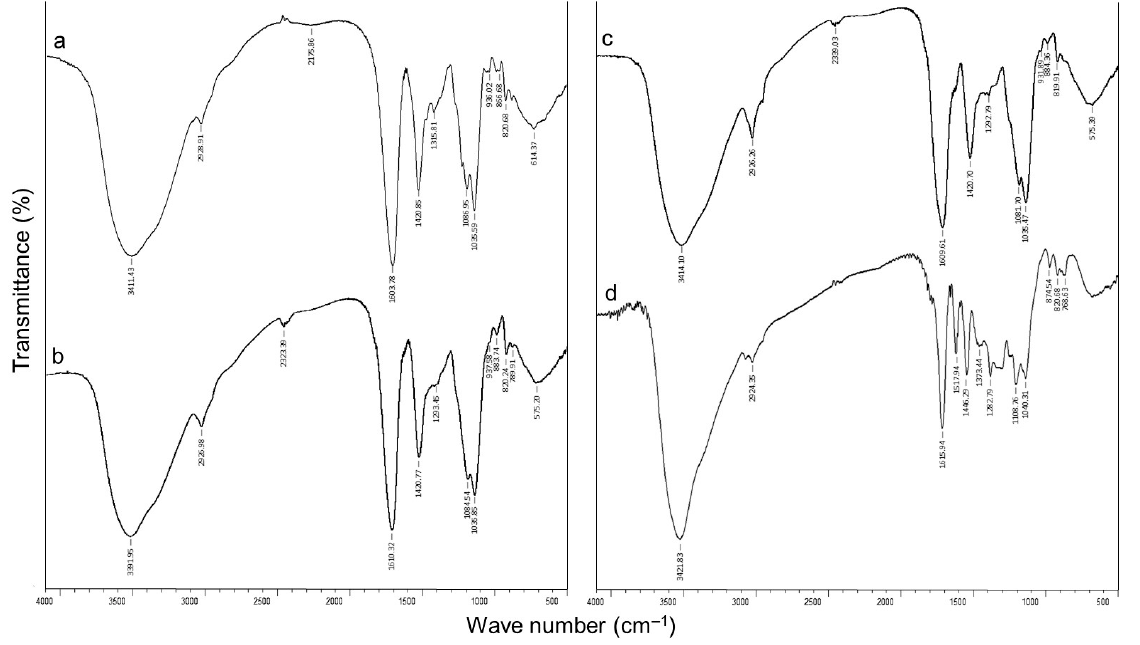
Figure 3. FTIR spectra of GSE-loaded Ca-alginate (Alg1.0) ( a ), alginate/callus particles (0.17SVC- 1.0Alg and 0.17LMC-1.0Alg) ( b , c ), and GSE ( d ). GSE-grape seed